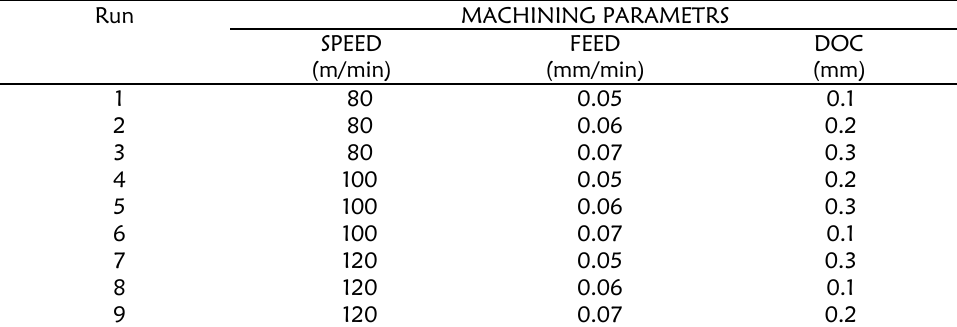
Table 3: Orthogonal array for machining